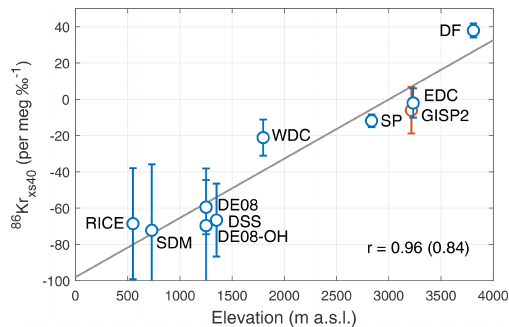
Figure A6. Kr-86 excess dependence on site elevation. The vertical axis is the 86 Kr xs . The linear fit has a slope of 34 per meg‰ − 1 per 1000m elevation.